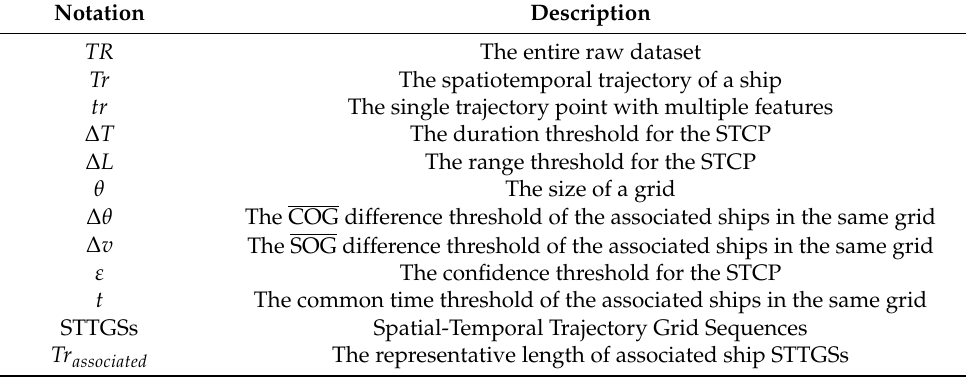
Table 2. Description of parameter